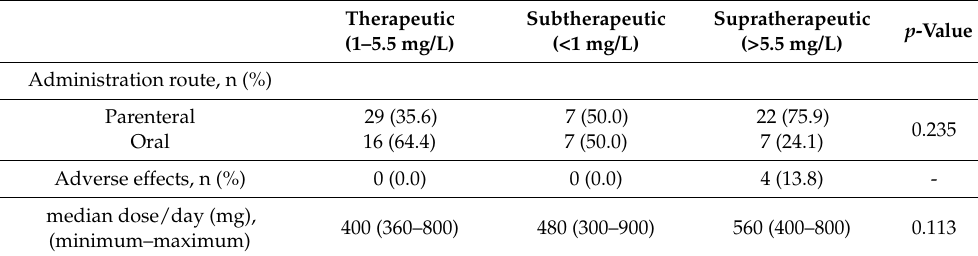
Therapeutic Subtherapeutic Supratherapeutic p -Value (1–5.5 mg/L) (<1 mg/L) (>5.5 mg/L)